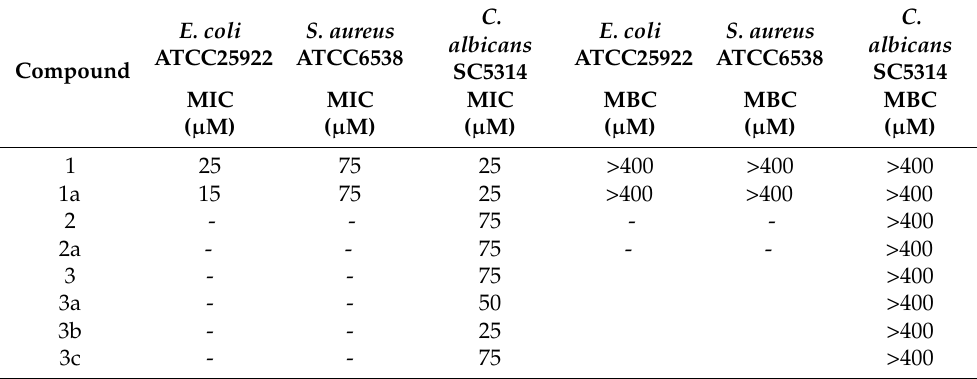
Figure 3. Inhibitory effect of ( a , b ) liquiritigenin and its methylated product 1a on S aureus ATCC6538, C. albicans SC5314, and E. coli ATCC25922; ( c , d ) naringenin 3 and its methylated product 2a on C. albicans SC5314; and ( e ) hesperidin and its methylated products 3a, 3b, and 3c on C. albicans SC5314. Data are presented as mean ± SD. Table 4. MIC and MBC of samples to E . coli ATCC25922, S. aureus ATCC6538, and C. albicans SC5314.